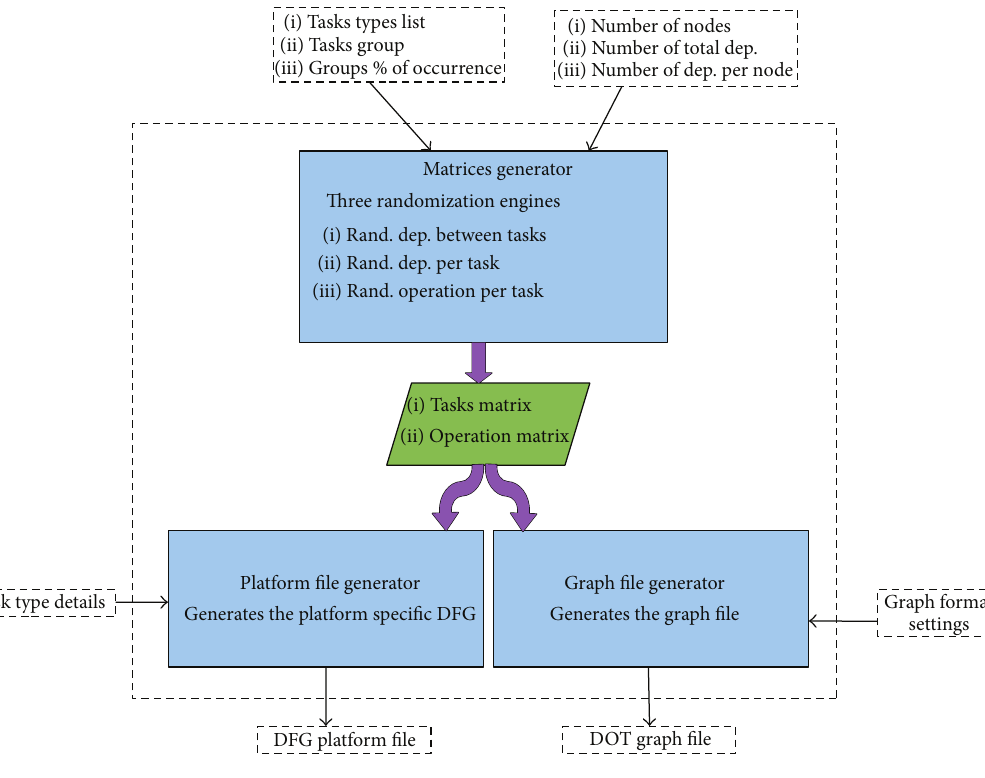
Figure 4: Components of the DFG generator.